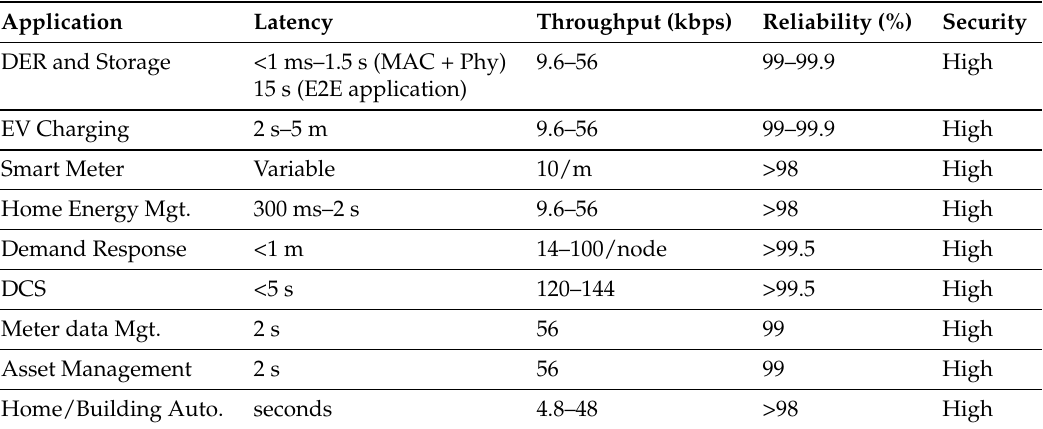
Table 2. MG applications and communication requirements [40,42,46,47]. DER: distributed energy resources; MAC: medium access control; E2E: end-to-end; EV: electric vehicle; DCS: distribution customer storage; Mgt.: management; Auto.: